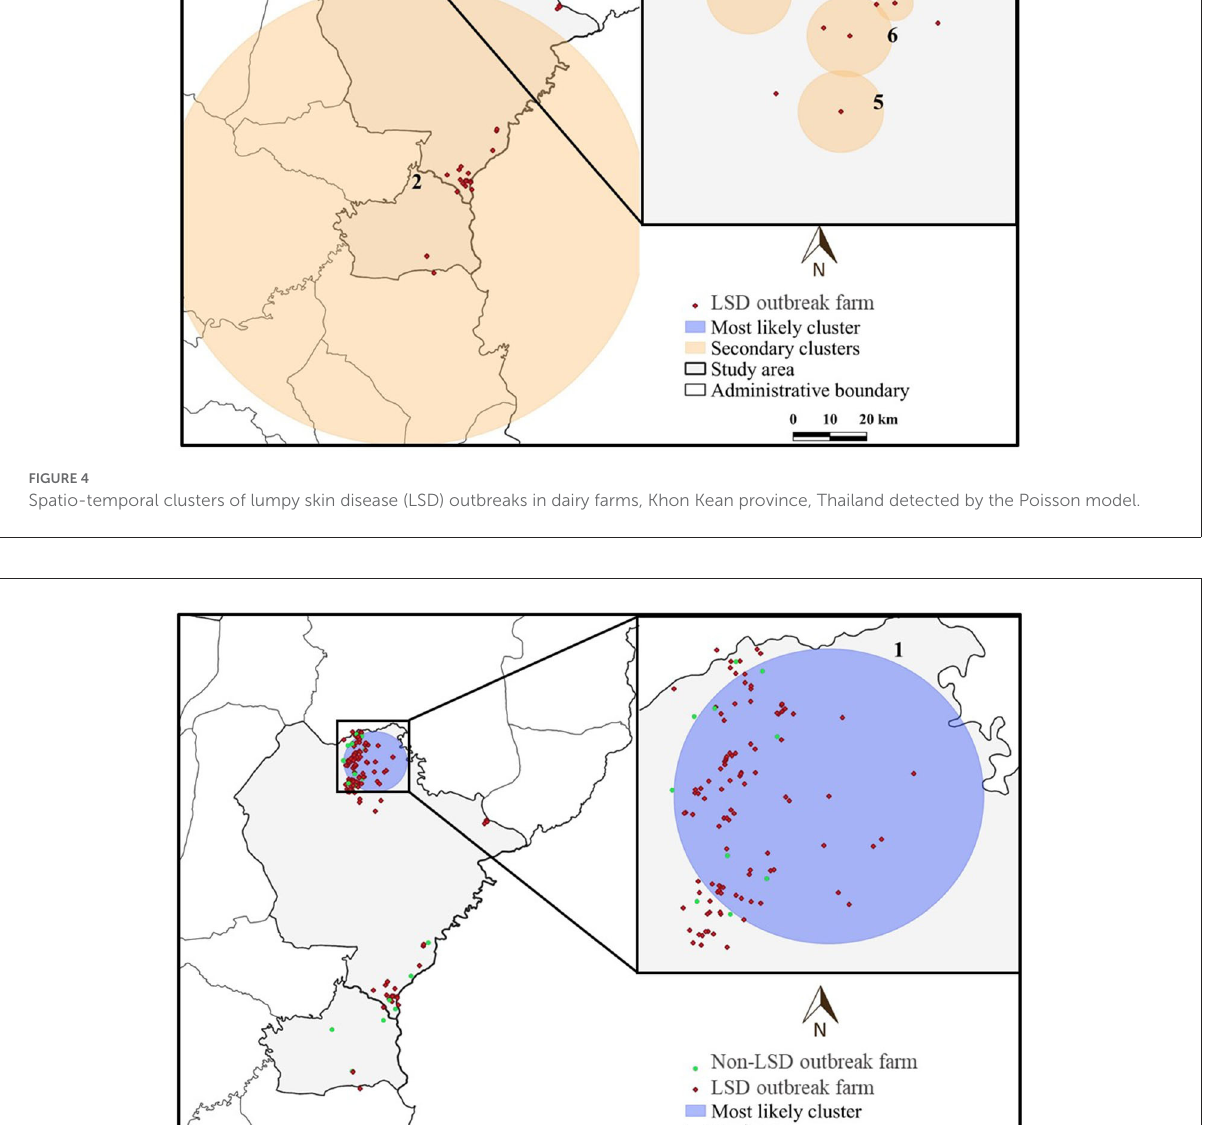
study conducted in beef farms in Thailand (23). This may be due to the fact that dairy farms are more intensive than beef farms, and therefore their disease prevention and control management practices are likely to be more rigorous (22). However, the